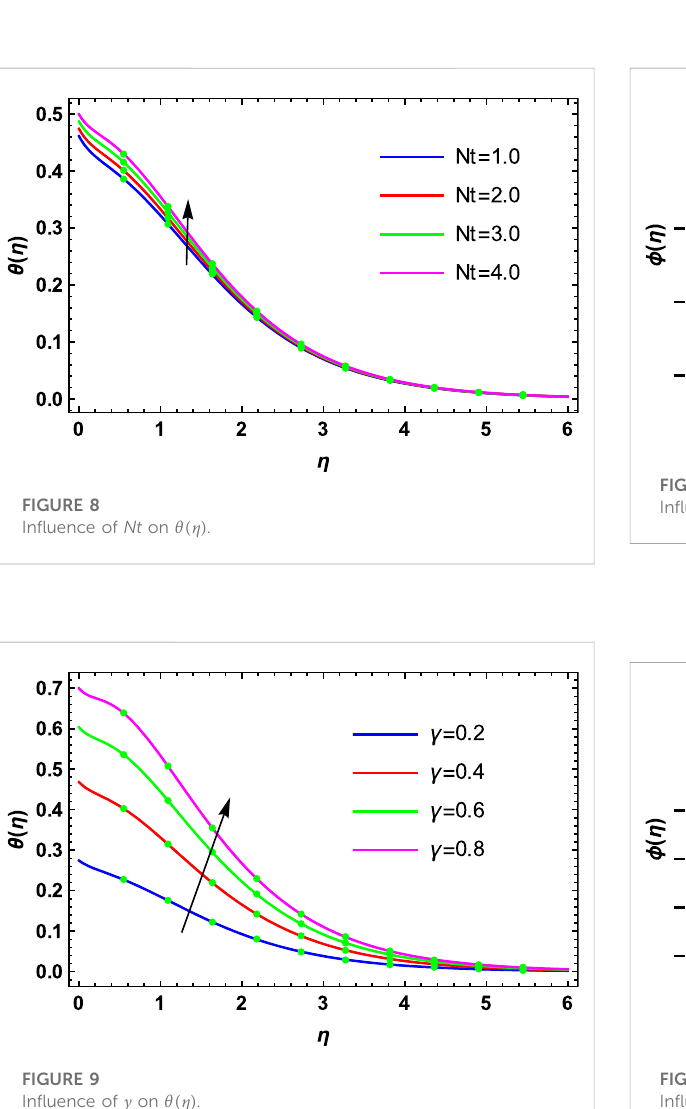
In fl uence of Sc on ϕ ( η )